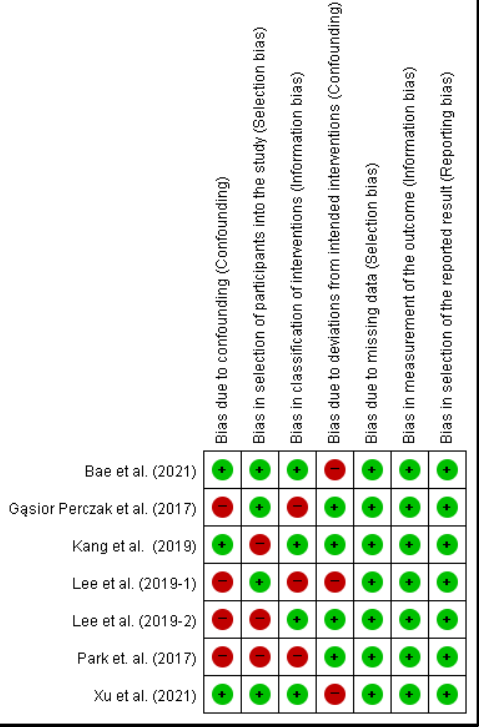
Figure 2. Risk of bias summary using ROBINS-I tool. (Red circle: high risk, green circle: low risk).